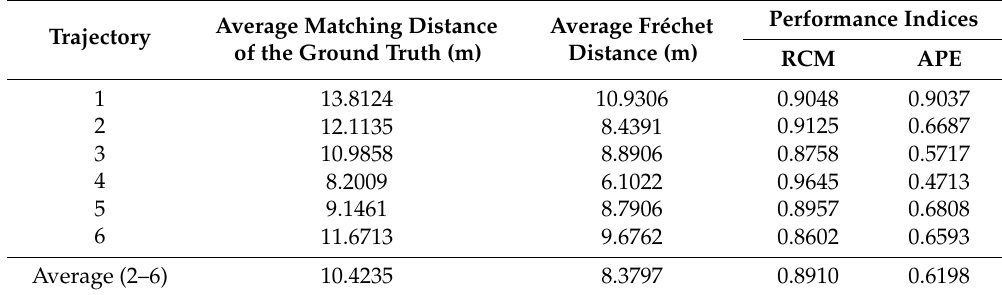
Table 5. Performance indices from map-matching by the adaptive Fréchet-distance-based method applied for Trajectories